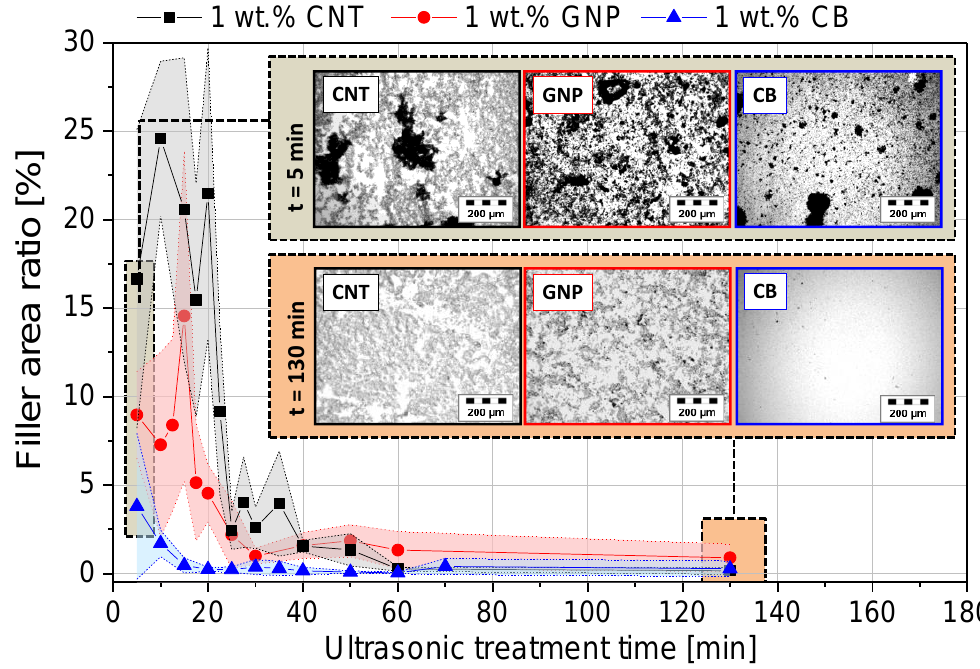
Figure 6. Development of the carbon filler macro-dispersion in aqueous PP emulsion tracked by optical light transmission microscopy using the primary filler area ratio.